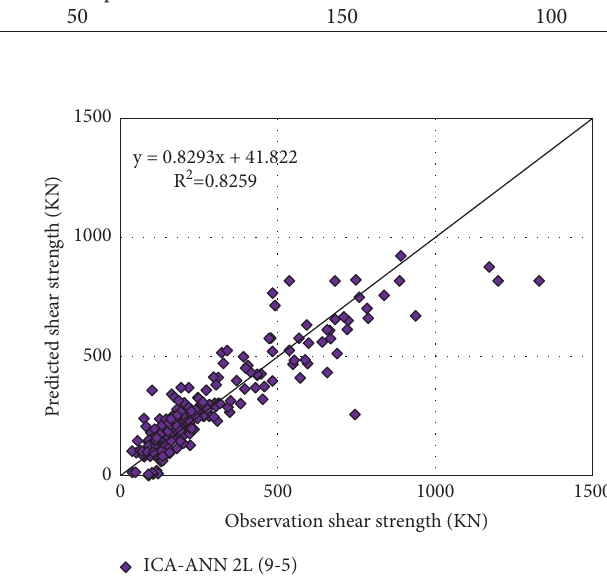
Figure 9: Target (experimental) versus predicted values of shear strength for ANN-ICA 2L (9-5) model using all data.